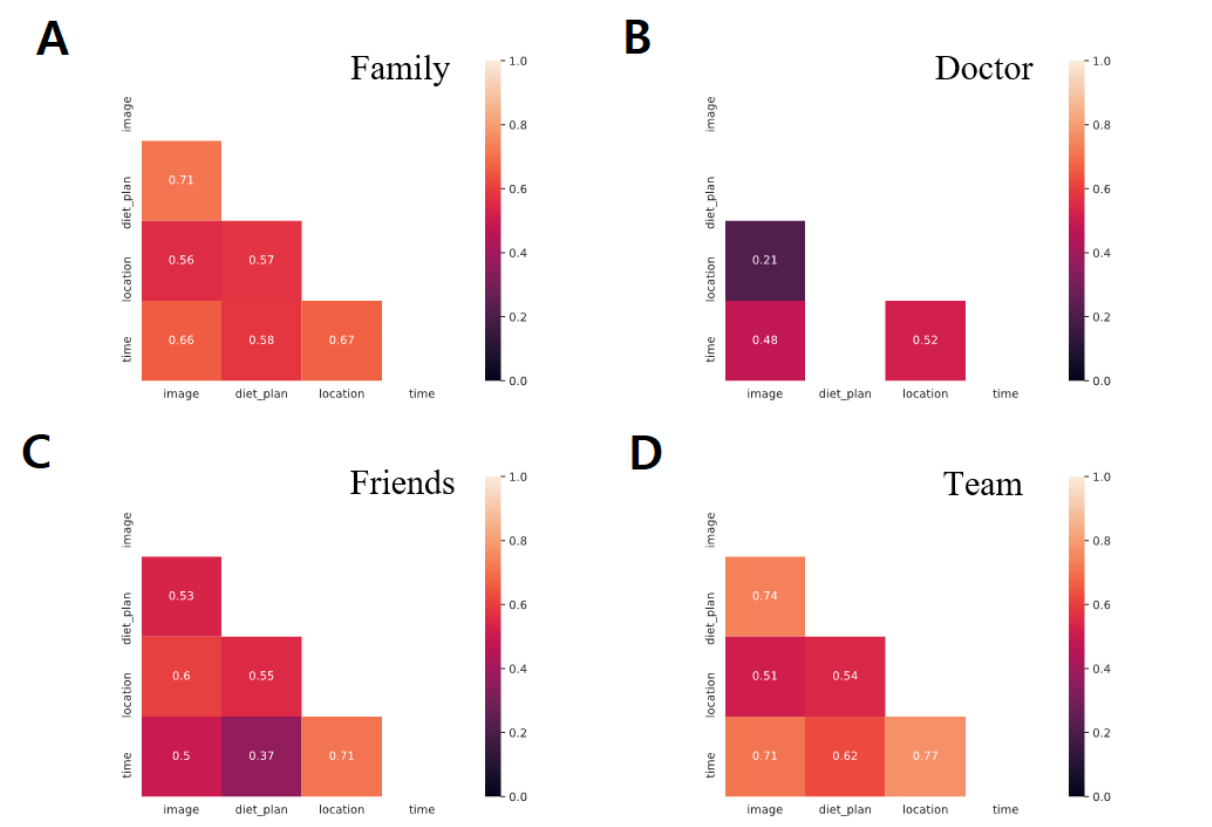
Figure 4. Pearson correlation values for sharing meta-information such as food image, diet plan, location and time between different social groups A. Family; B. Doctor; C. Friends; D. Team. The values indicate the correlation between the willingness, or lack thereof, to share